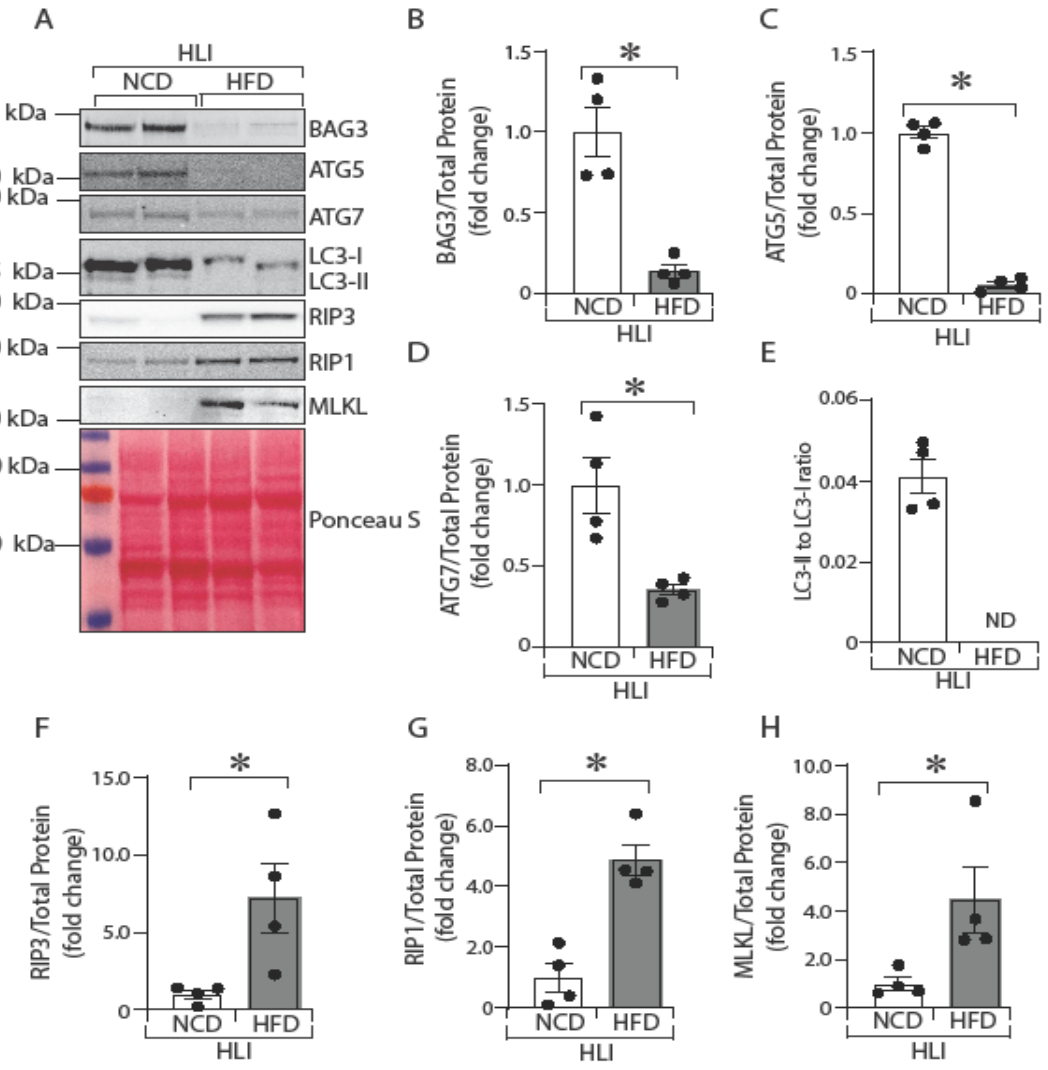
Figure 4. Ischemic skeletal muscle in diabetic mice shows decreased autophagy and increased necroptosis. C57BL/6J mice were fed with HFD for 16 weeks, and HLI was performed. After 3 days of HLI, GA muscle samples were collected, protein lysates were prepared, and BAG3 ( A , B ) n = 4, ATG5 ( A , C ) n = 4, ATG7 ( A , D ) n = 4, LC3-II/-I ratio ( A , E ) n = 4, RIP3 ( A , F ) n = 4, RIP1 ( A , G ) n = 4, and MLKL ( A , H ) n = 4 were quantified by Western blotting. The protein band was quantified and normalized to total protein from Ponceau S staining. The results are presented as fold changes vs. NCD. ND = not determined (because of undetectable band intensity). All the values are mean ± SEM. * p < 0.05 vs. NCD.